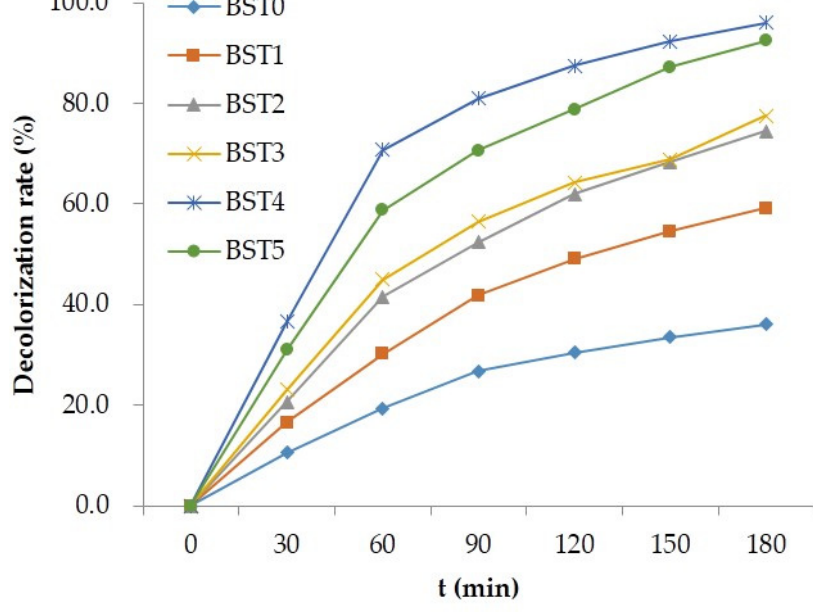
Figure 7. The decolorization rate of Rhodamine B from different Bi-doped wood samples.